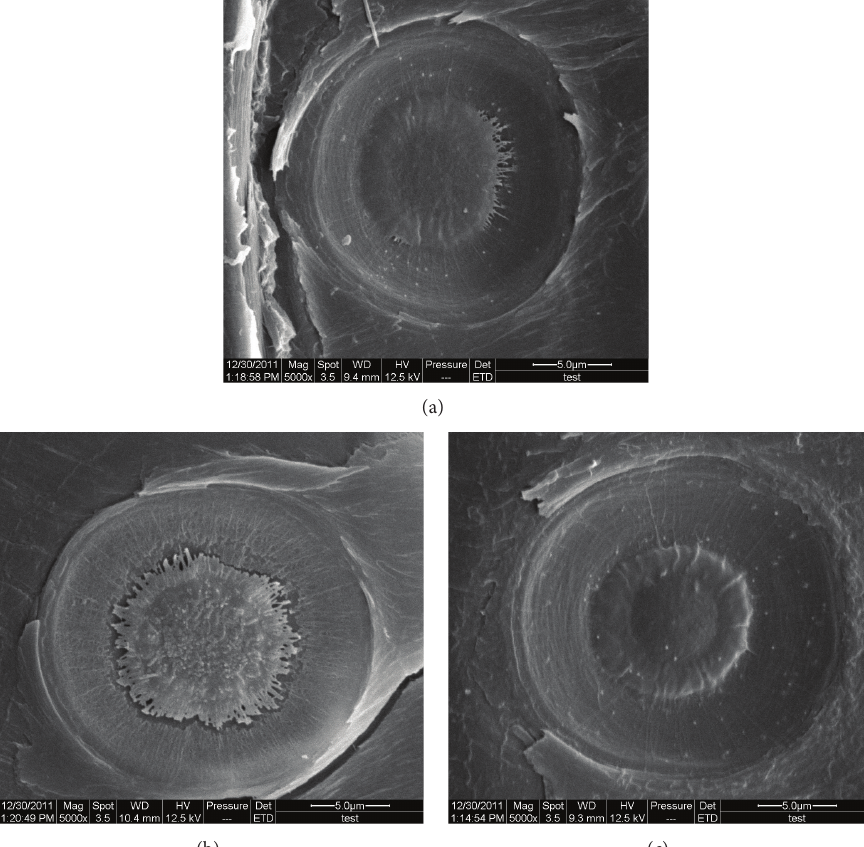
Figure 4: SEM images L. gmelinii . (a) Untreated sample. (b) Sample after UAE. (c) Sample after